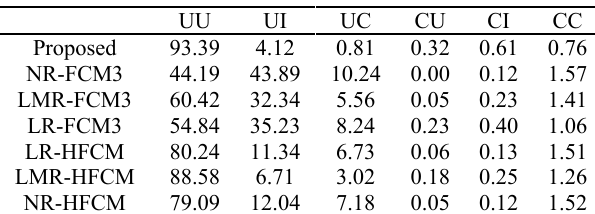
Table 5. Proportion (%) of different class obtained on Yamenkou dataset.